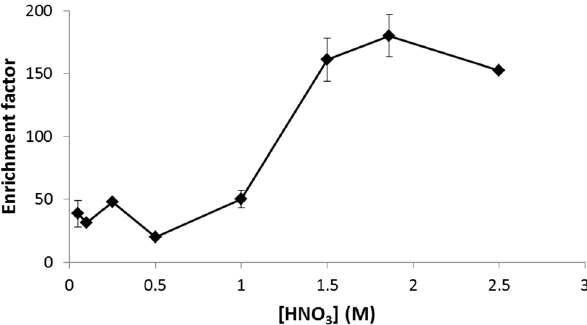
Figure 4. Effect of HNO 3 concentration in the acceptor solution on the enrichment factor. Sample